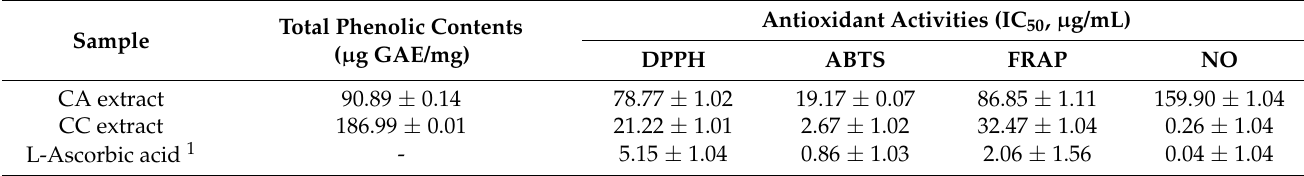
Table 1. Total phenolic contents and antioxidant activities of CA and CC extracts.